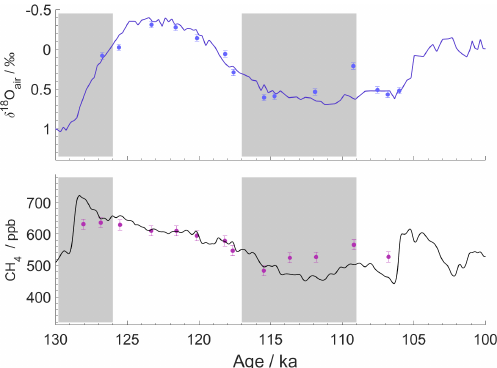
Figure 12. Reference data for CH 4 and δ 18 O atm between 100 and 130ka (as in Fig. 8a), along with discrete measurements (symbols) for the Skytrain Ice Rise ice core. Sections with unreliable ages (605–617 and > 627m) are greyed out. The error bars are the com- bined uncertainty (at 1 σ ) of the Skytrain and reference